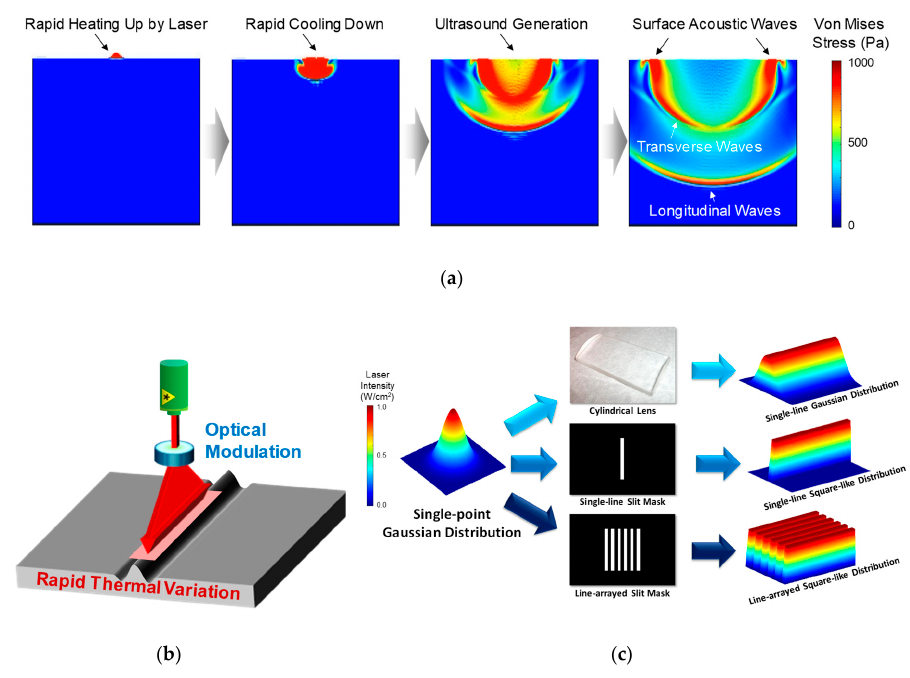
Figure 3. The process of the generation of a surface acoustic wave; ( a ) the generation of ultrasounds due to thermal stress by a pulsed laser shot; ( b ) the rapid thermal variation due to laser energy; ( c ) the intensity distribution according to optical modulation.